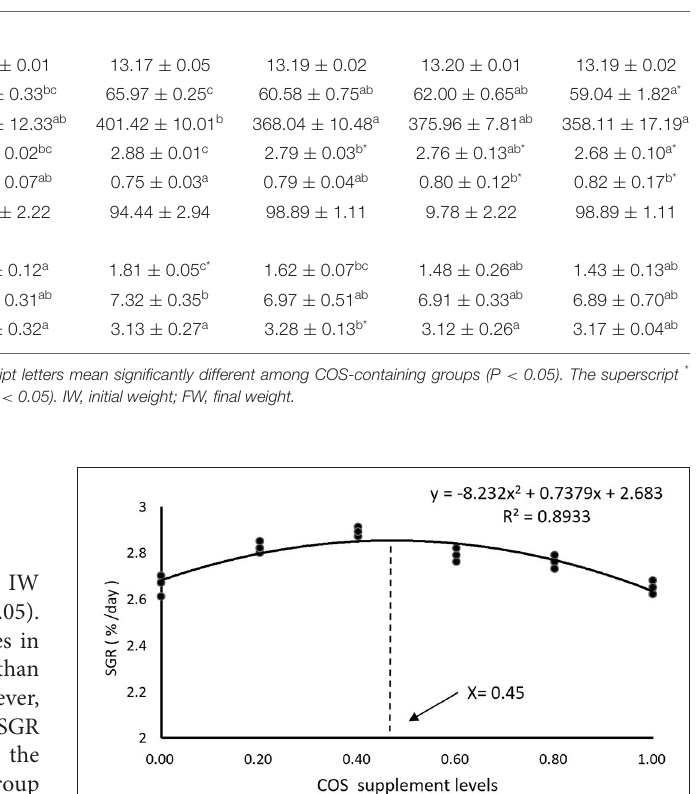
Intestinal Morphology Figure 2 shows the intestinal morphology of the hybrid